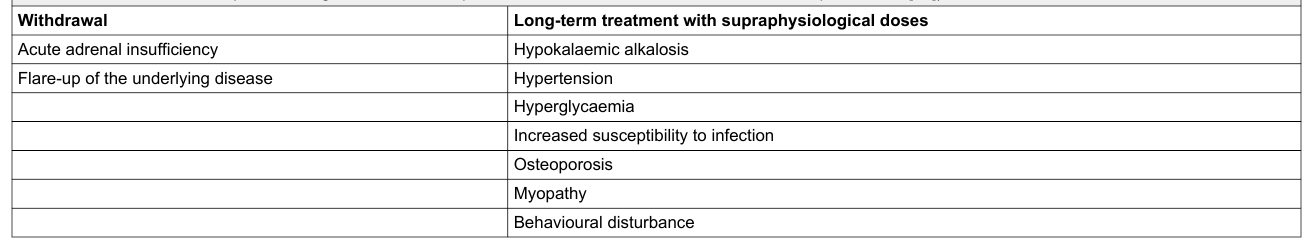
Table 3: Principal adverse effects (adapted from Schimmer BP, Funder JW. ACTH, Adrenal steroids, and pharmacology of the adrenal cortex. In: Brunton LL, editor. Goodman and Gilman’s The pharmacological basis of therapeutics. 12th ed. New-York: McGraw-Hill; 2011. p. 1209–35 [67]). Withdrawal Long-term treatment with supraphysiological doses Acute adrenal